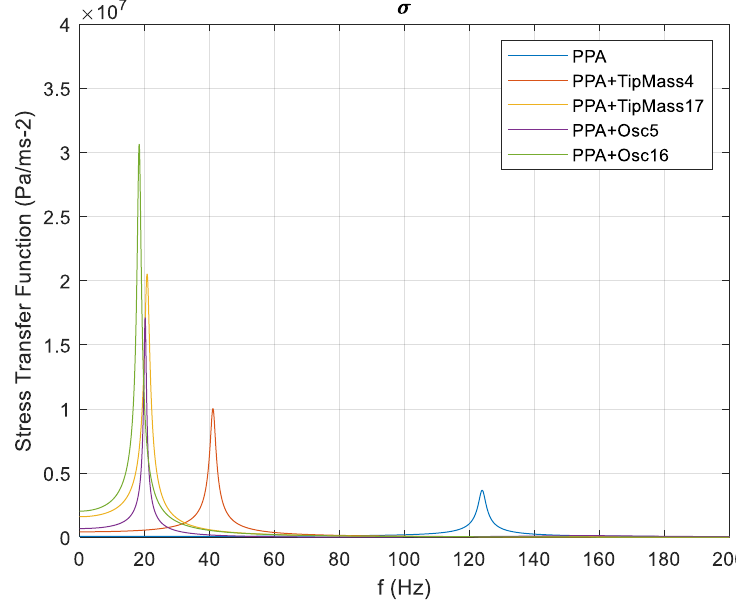
Figure 8. Maximum stress inside the piezo electric layer.